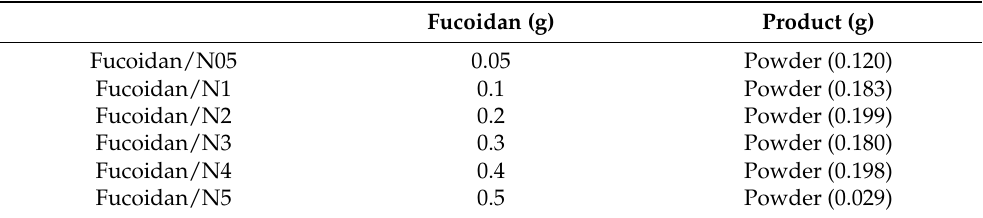
Table 1. Non-gel polymerization of aniline in the presence of fucoidan with oxidative chemical